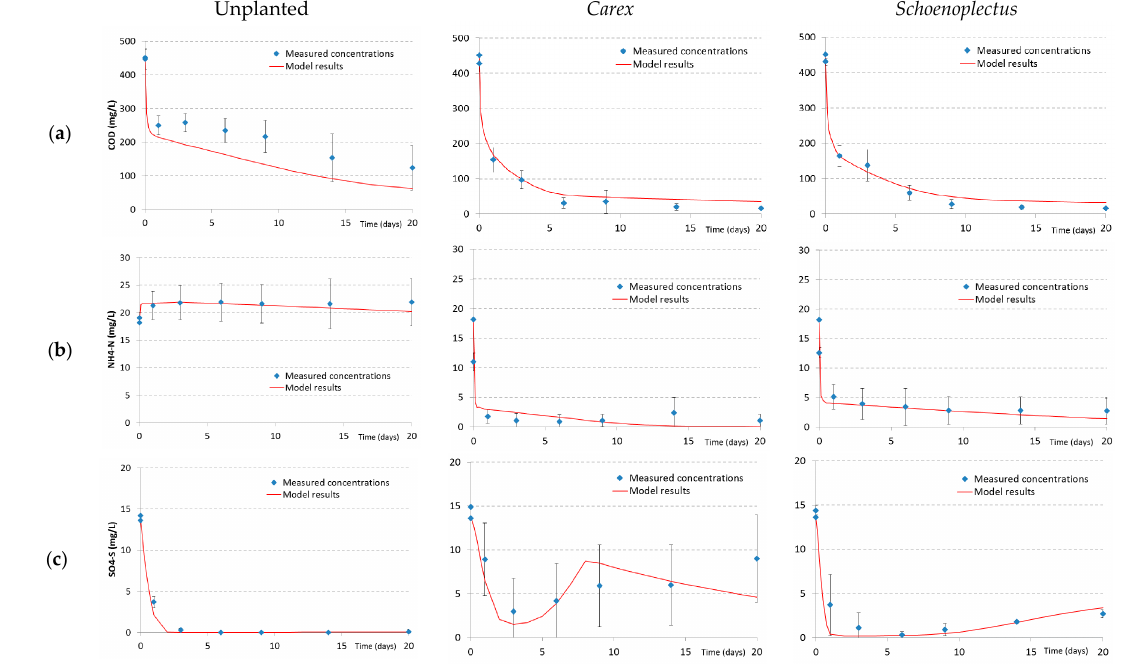
Figure 7. Simulation results for COD ( a ) NH 4 ‐ N ( b ) and SO 4 ‐ S ( c ) at 12 °C for unplanned columns, and columns planted with Carex and Schoenoplectus . Continuous line: simulation results, dots: measurement means, intervals: standard deviation (adapted from [28]).